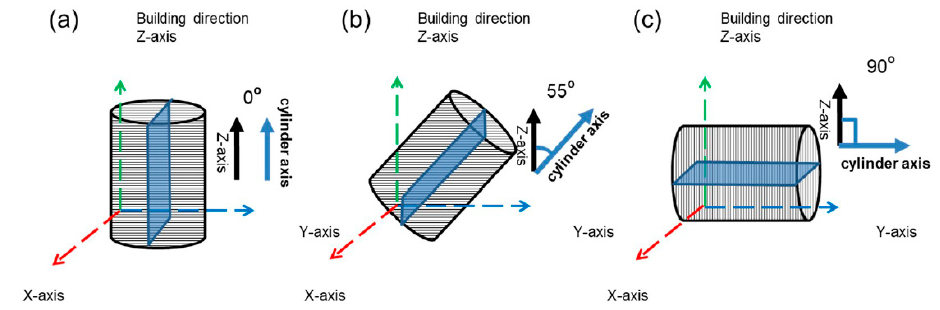
Figure 1. Schematic representation of three-dimensional diagram of electron beam melting (EBM)-In718 alloy columnar specimens with a size of ( Φ 15 × 85 mm) and the planes used for experiments: